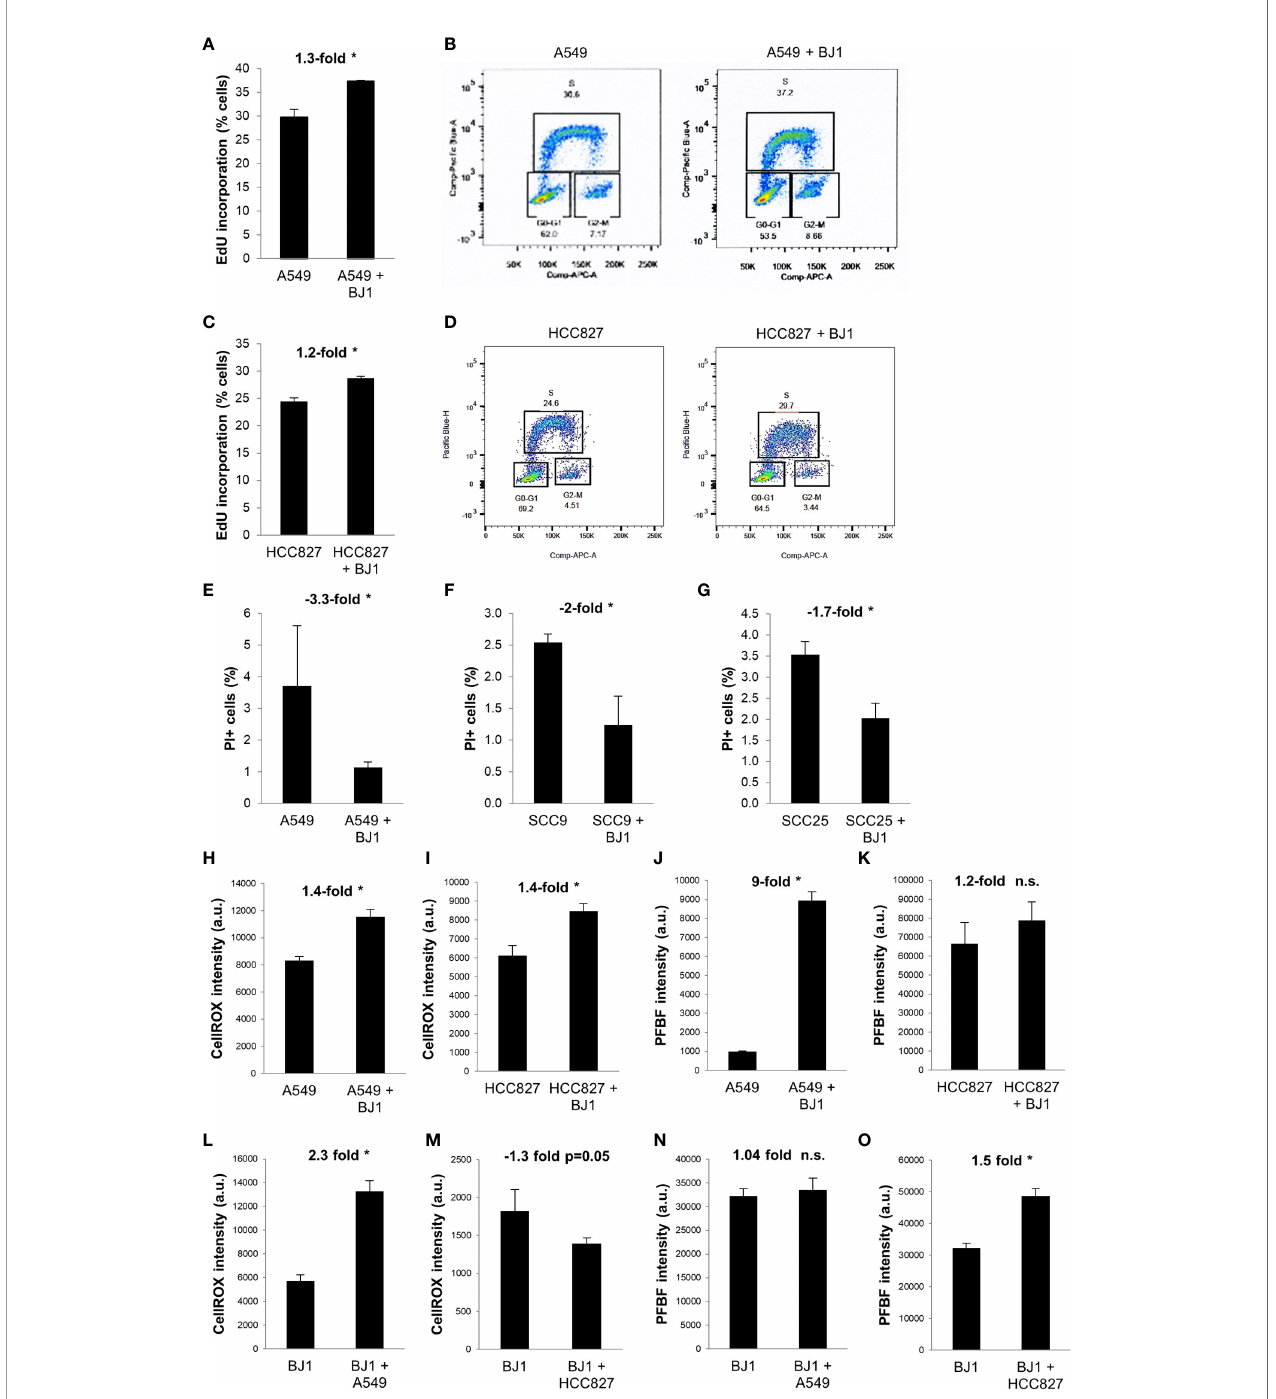
FIGURE 4 | Effects of fi broblasts on ADT carcinoma cell aggressiveness. Human ADT carcinoma cells were monocultured or co-cultured with GFP-tagged BJ1 and proliferation, cell death and oxidative stress levels were assessed by fl ow cytometry. (A, C) Percentage of A549 (A) and HCC827 (C) in the DNA synthesis phase, measured by 5-ethynyl-2 ’ -deoxyuridine (EdU) incorporation. (B, D) Representative fl ow cytometry plots showing percentage of A549 (B) and HCC827 (D) in each phase of the cell cycle, and gating strategy for EdU (Paci fi c Blue) and FxCycle (APC) staining. (E – G) Percentage of cell death as measured by propidium iodide (PI) staining in A549 (E) , SCC9 (F) and SCC25 (G) . (H, I) Reactive oxygen species (ROS) levels, as measured by the CellROX probe, in A549 (H) and HCC827 (I) . (J, K) Hydrogen peroxide (H 2 O 2 ) levels, as measured by the PFBF probe, in A549 (J) and HCC827 (K) . (L, M) ROS levels in BJ1 in monoculture or in co-culture with A549 (L) and HCC827 (M) . (N, O) H 2 O 2 levels in BJ1 in monoculture or in co-culture with A549 (N) and HCC827 (O) . Student ’ s t-test was used for statistical analyses (* p<0.05). (a.u., arbitrary units). ns, not signi fi